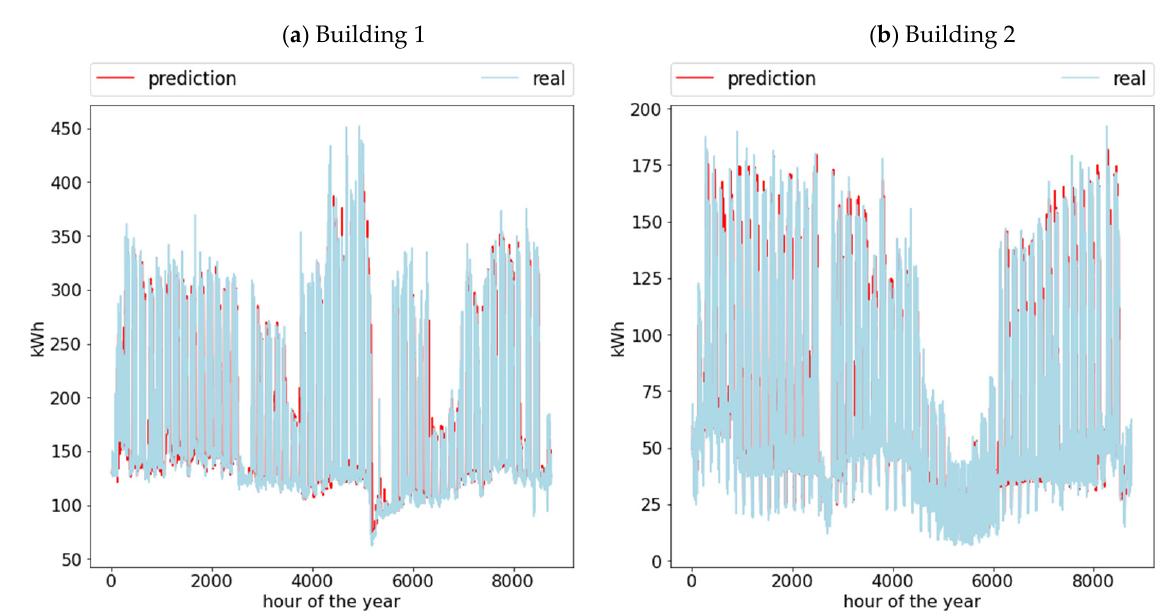
Figure 8. ( a ) Real versus predicted energy consumption for building 1; ( b ) real vs. predicted energy consumption for building 2.